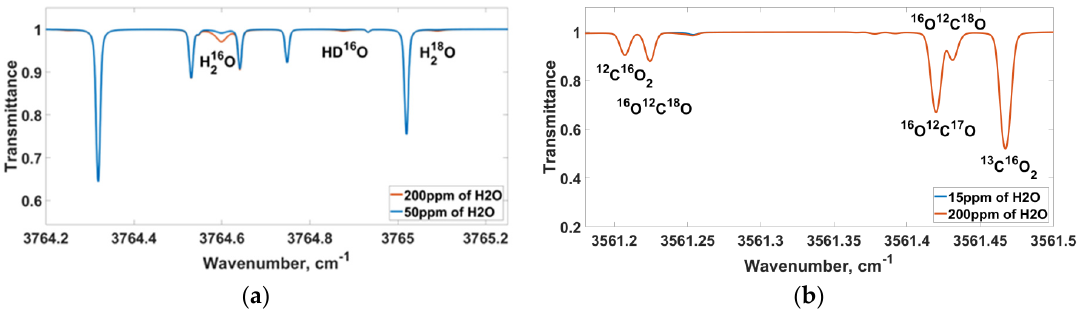
Figure 1. Synthetic transmission spectra of a near-surface layer of Martian atmosphere: ( a ) 2.656 µm at a pressure of 30 mbar; ( b ) 2.808 µm at a pressure of 5 mbar.